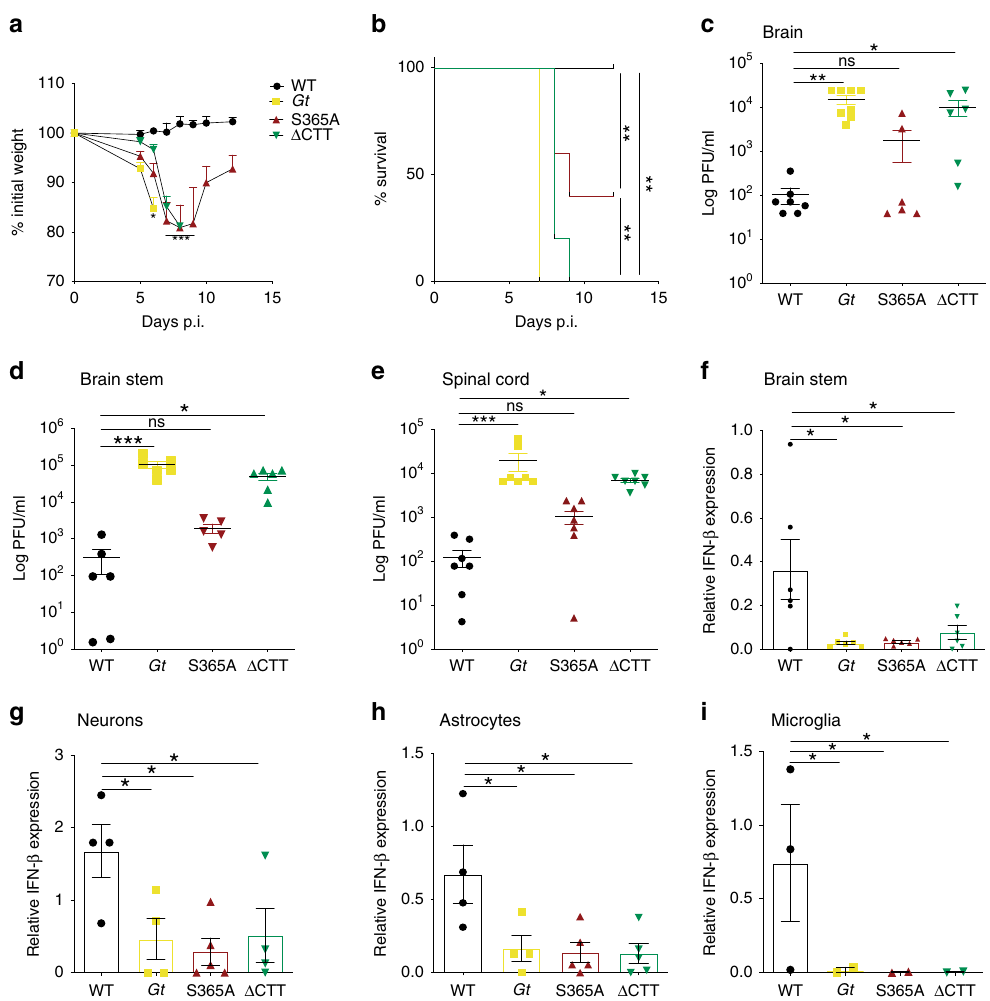
Fig. 4 S365A mice are resistant to ocular HSV-1 infection. Mice were infected via the ocular route with 1 × 10 5 PFU of HSV-1 (strain 17). a Percentage of initial weight following infection. b Survival of infected mice. c Viral titers in the brain, d brain stem, and e spinal cord from 6 days p.i. f Relative expression of Ifnb in the brain stem at 3 days p.i. g Brains from infected mice were collected 3 days p.i. and neurons, h astrocytes, and i microglia cells were sorted, and Ifnb expression was analyzed. a , b n = 7 mice per genotype . a , b Representative of more than fi ve independent experiments, each yielding similar results. c – f n = 3/4 mice per genotype. Combined results from two independent experiments, each yielding similar results. More than fi ve independent experiments were performed. g , h n = 4 mice per genotype, i n = 3 mice per genotype. g – i Representative of two independent experiments, each yielding similar results. Center and error bars show mean and SEM. Analyzed with one-way ANOVA and Tukey post-test. * p ≤ 0.05; ** p ≤ 0.005; *** p ≤ 0.0001. ns not signi fi cant. Exact p values are given in the Supplementary Both strains were used for infection of mice, while only KOS strain was used for in vitro stimulation.